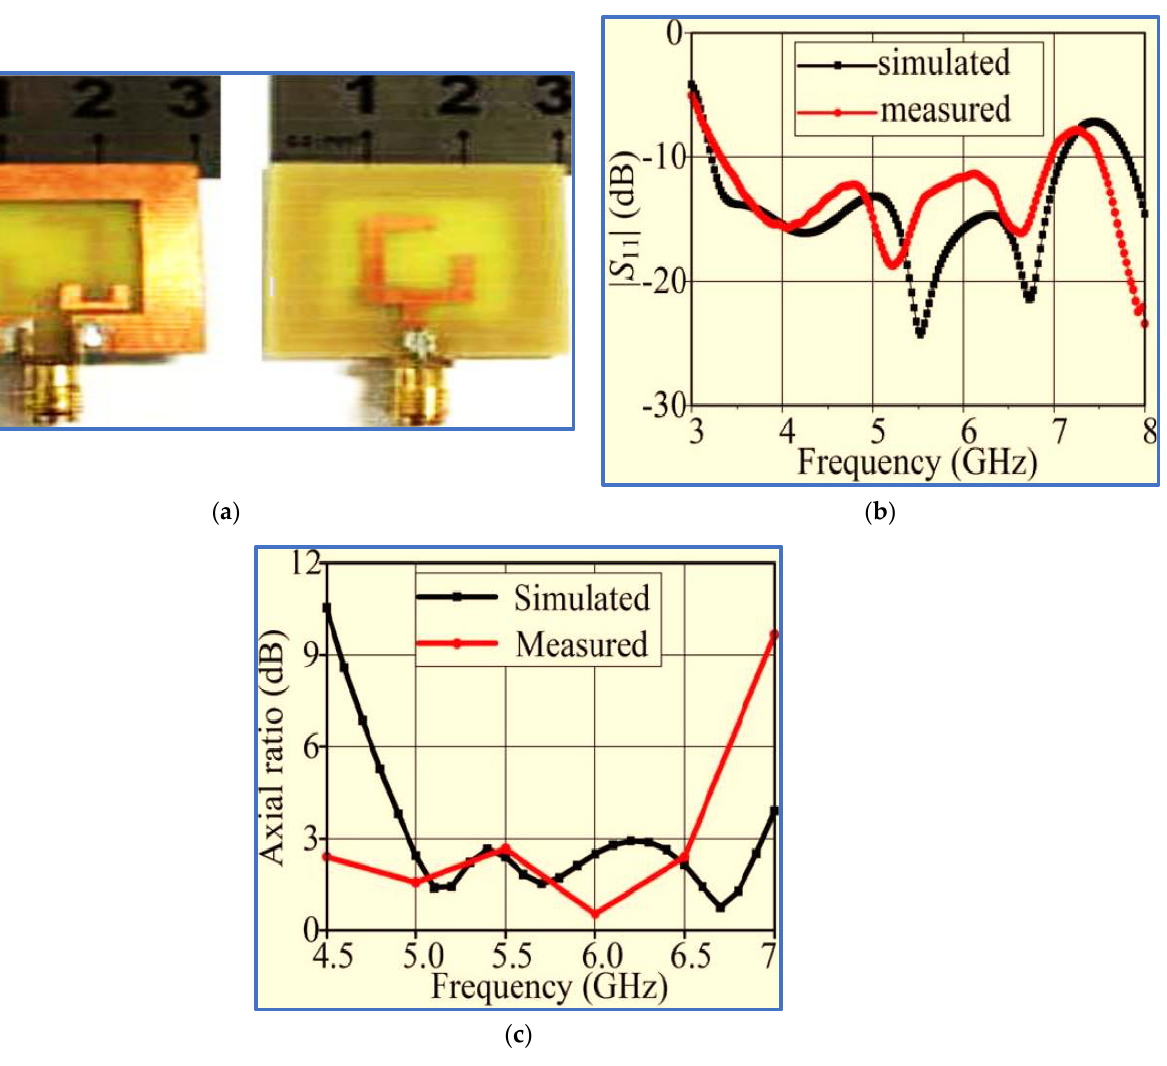
( b ) Figure 11. Geometry of a C-shaped slot antenna: ( a ) the dimensions of the proposed antenna and ( b ) the fabricated design [11]. Figure 12a shows the square CP slot antenna based on a G-shaped feed line proposed by Oteng Gyasi et al. [89]. A new impedance transformation method was used in this work by cutting one side of the feed line and introducing a small horizontal slot in the near middle portion of the feed line to enhance the impedance matching between the G-shaped radiator and the 50 Ω feeding port of the antenna. To extend the IBW, the authors embed-